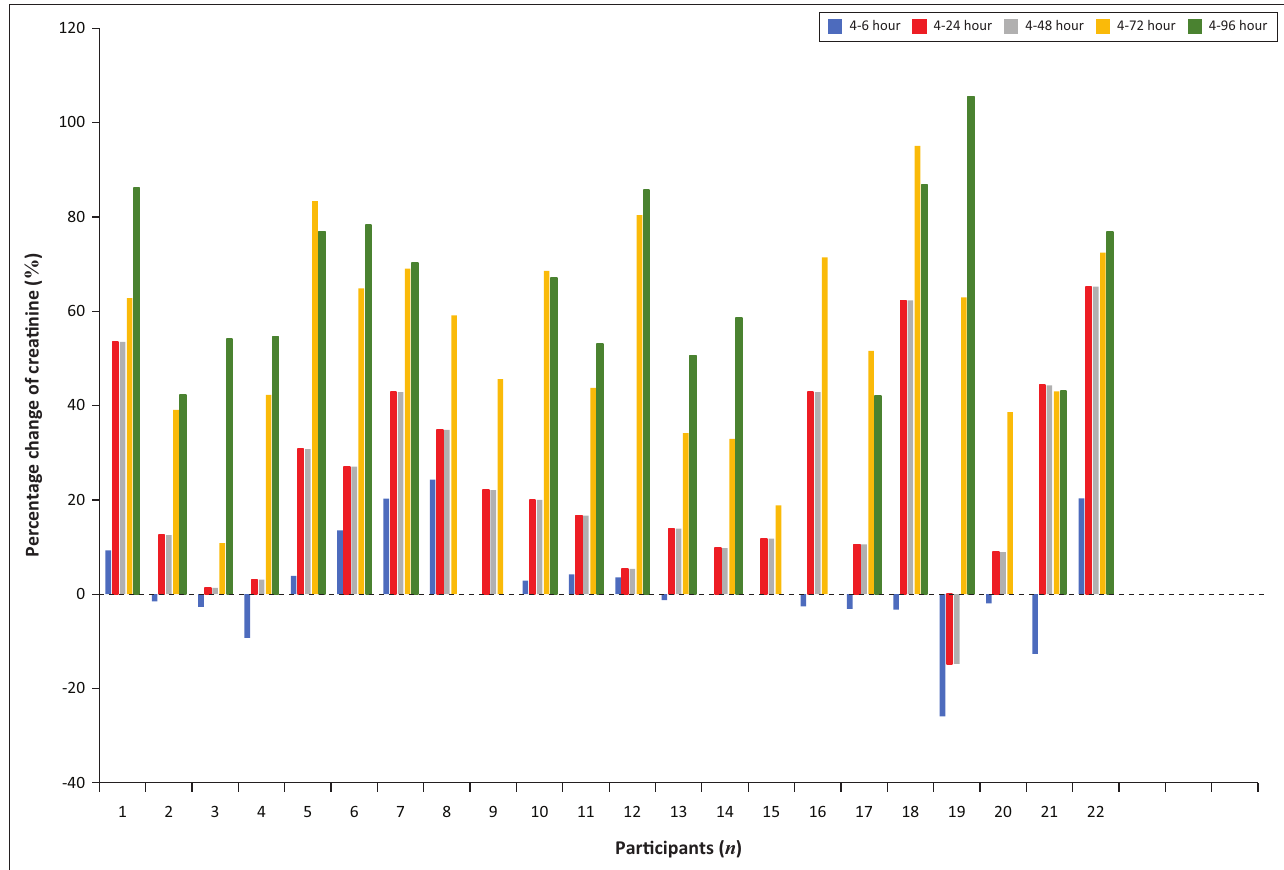
FIGURE 2: Percentage change in serum creatinine concentrations obtained using the kinetic Jaffe method over 96 h for 22 participants relative to the serum creatinine results at 4 h. Percentage change to baseline (4 h): blue bars = 4–6 h, orange = 4–24 h, grey = 4–48 h, yellow = 4–72 h, green = 4–96